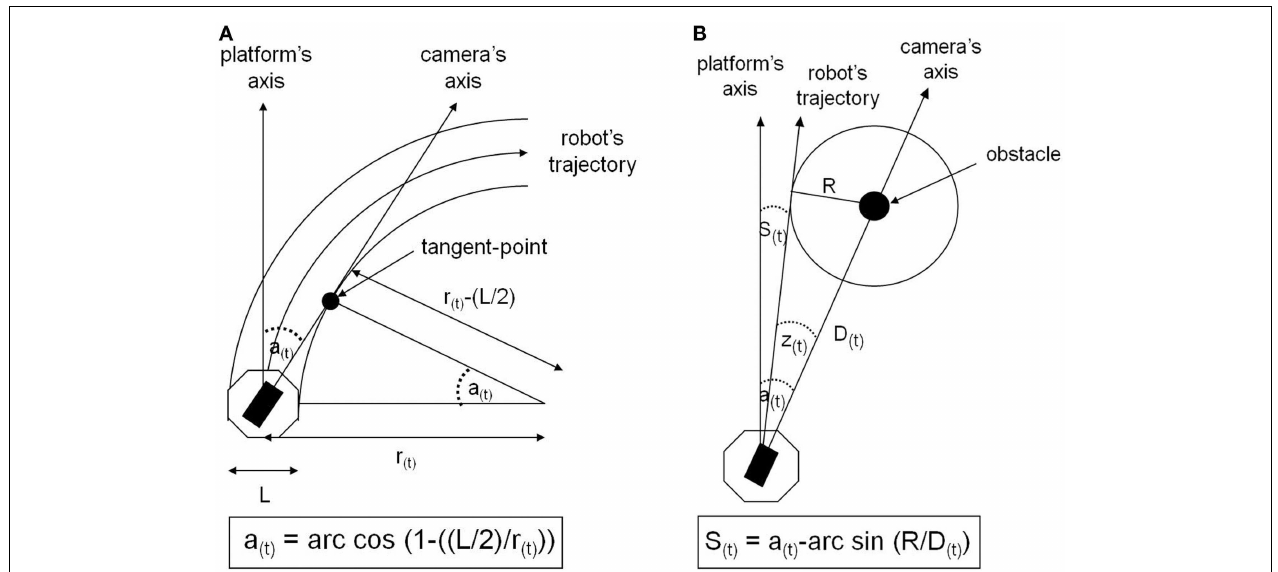
difference between the angle ( a ), between the direction of the camera and the heading of the robot, and the angle ( z ), between the direction of the camera and the tangent to the orbit of safety ( R ).This angle z is calculated by using trigonometric rules in such a way that sin z ( t ) = R/D ( t ) . D, the distance between the robot and the landmark, is obtained by the ratio of the rate of change of the camera angle to velocity, such as D = ( v/ ( da/dt ) · sin a.